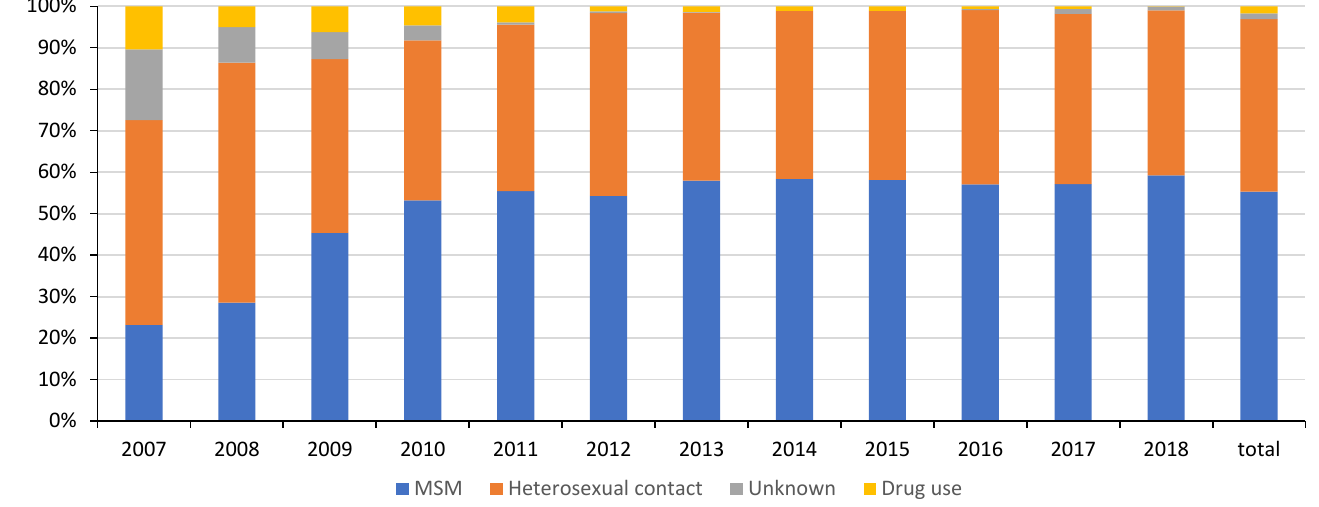
Figure 2. Trends of distribution of transmission routes of HIV newly diagnosed cases in Hangzhou, 2007 – 2018.